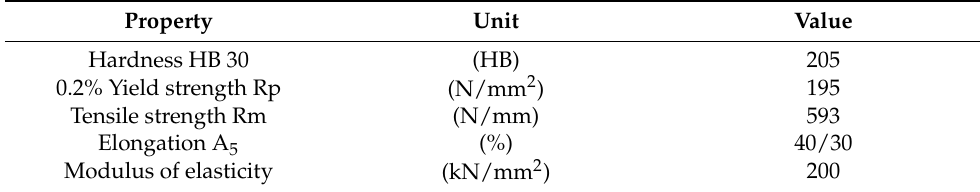
Table 3. Mechanical properties of 1.4541 (20 ◦ C) [20].